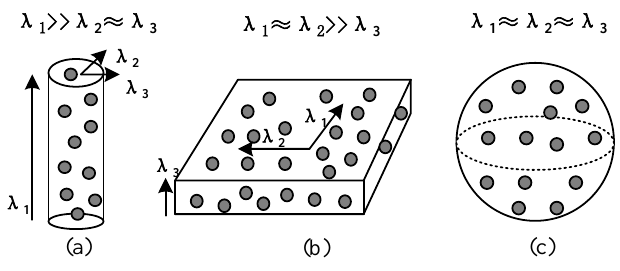
Figure 7 . Illustration of the saliency features: ( a ) Linearity; ( b ) planarity; ( c ) sphericity.